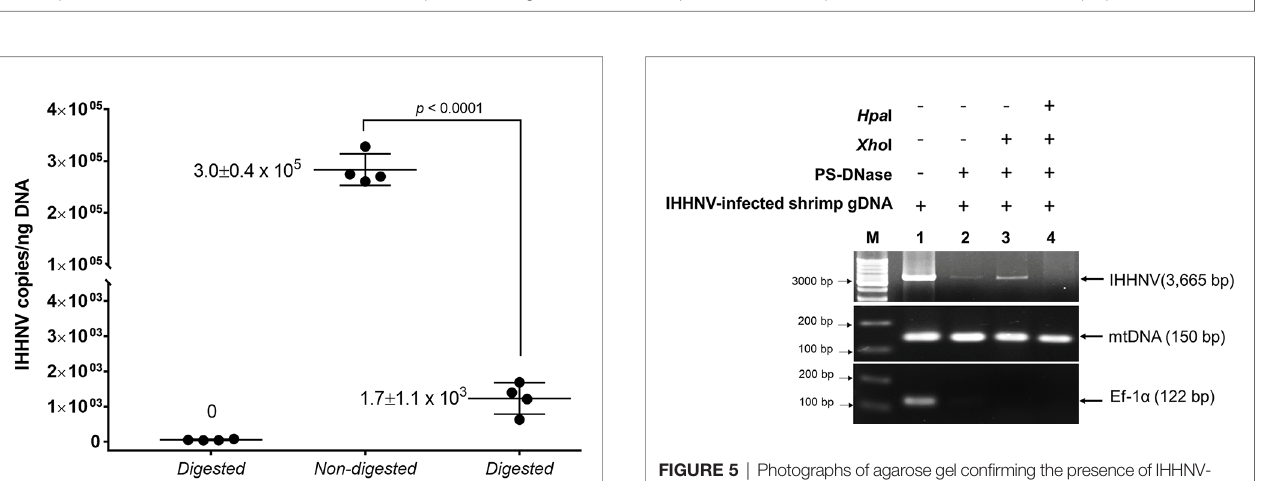
FIGURE 3 | Photographs of agarose gels show amplicons from total DNA extracts of IHHNV-negative shrimp ( P. monodon ) and IHHNV-infected samples before digestion and after digestion without (-) and with both Xho I and PS-DNase digestion (+), respectively. PCR detection using mitochondrial DNA (mtDNA) primers and EF-1 a primers as markers showed loss of an EF-1 a amplicon after digestion but retained presence of the amplicon for circular mtDNA for both preparations.